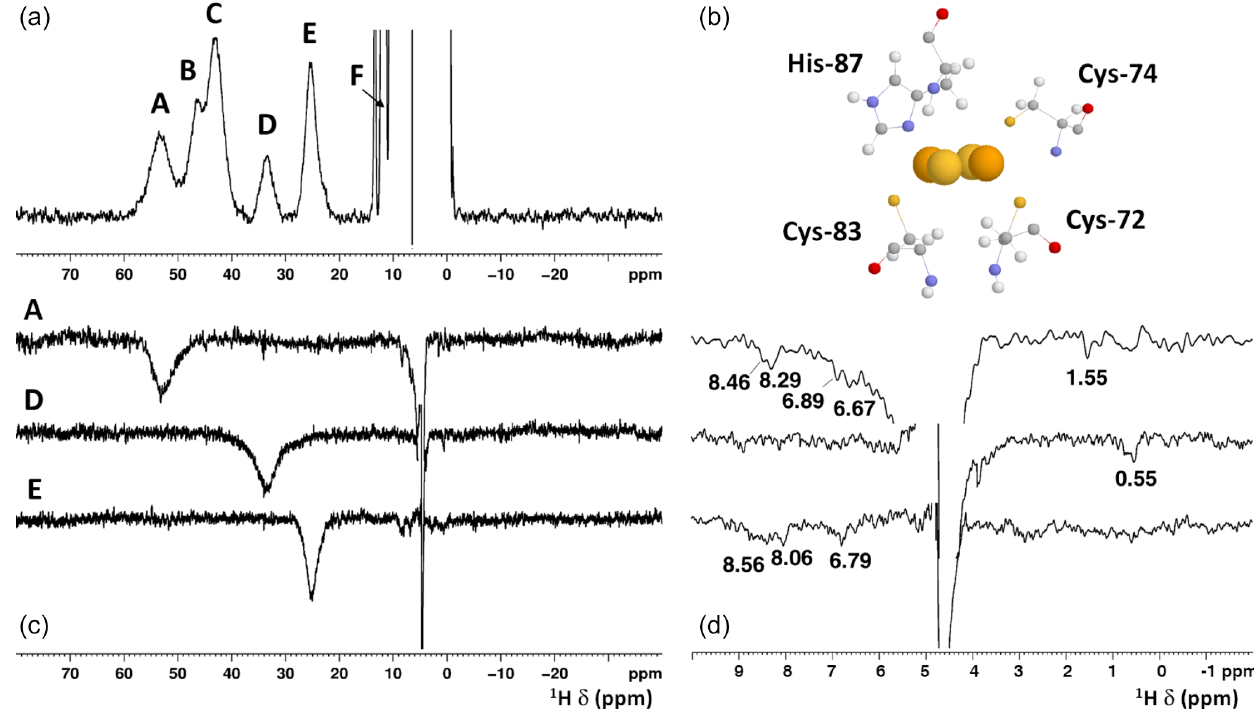
Figure 2. (a) 1 H NMR spectrum of oxidized [ Fe 2 S 2 ] 2 + mitoNEET, at 600MHz, 283K; (b) the cluster-binding residues are shown (PDB ID: 2QD0; Lin et al., 2007, protonated with UCSF Chimera). (c) 1D NOE difference experiments on oxidized [ Fe 2 S 2 ] 2 + mitoNEET at 600MHz, 283K. The letters indicate the signals which have been selectively irradiated to obtain the difference experiment; (d) for each of the 1D NOE difference experiments reported on (c) , the 10–0ppm region of the spectrum is shown. Peaks observed in the difference experiments are indicated by their chemical